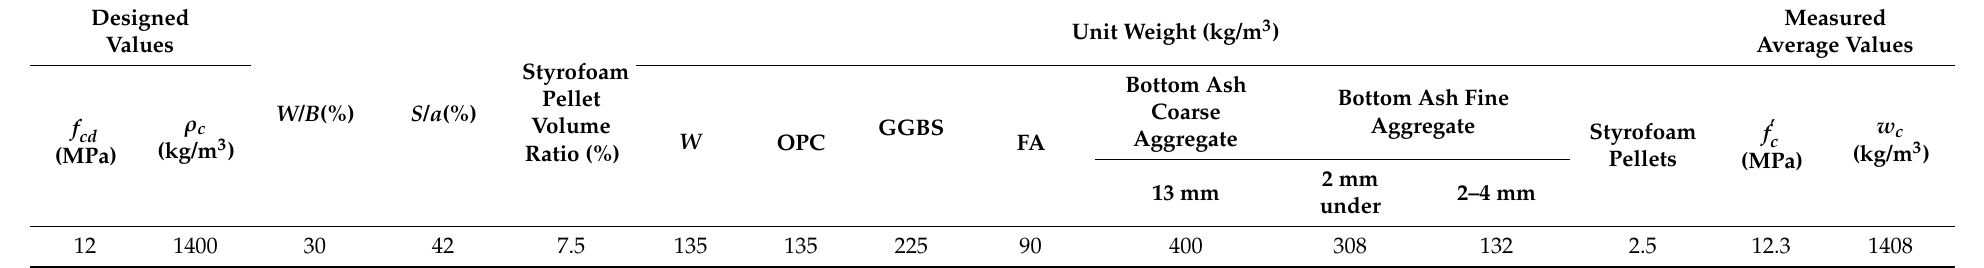
Table 2. Mixture proportions of lightweight concrete with